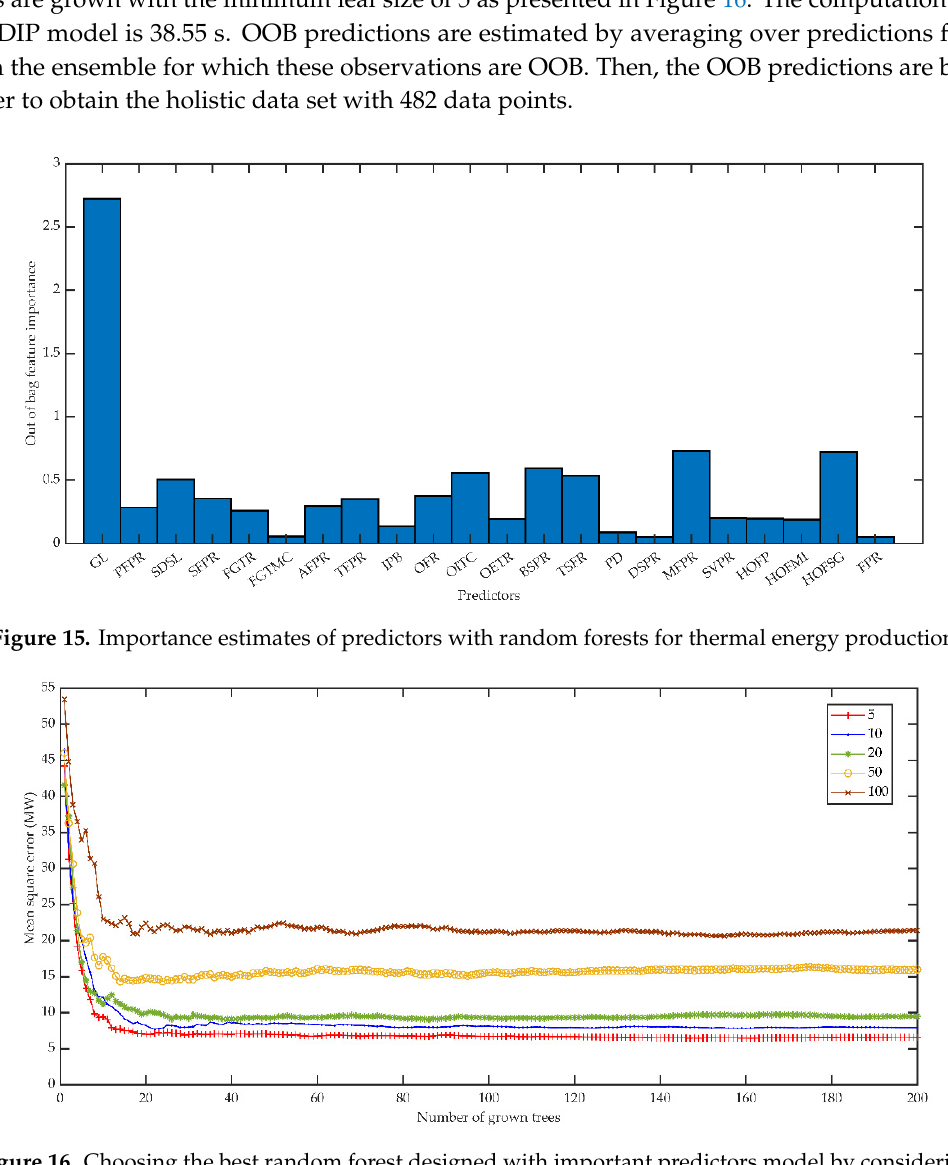
Figure 16. Choosing the best random forest designed with important predictors model by considering MSE with respect to the number of grown trees and leaf sizes.